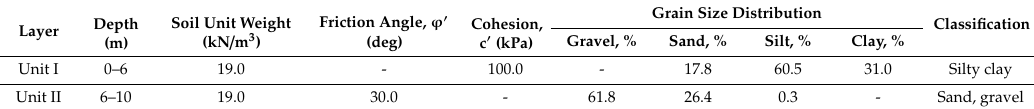
Table 1. Best estimated soil parameters at the Øysand slope